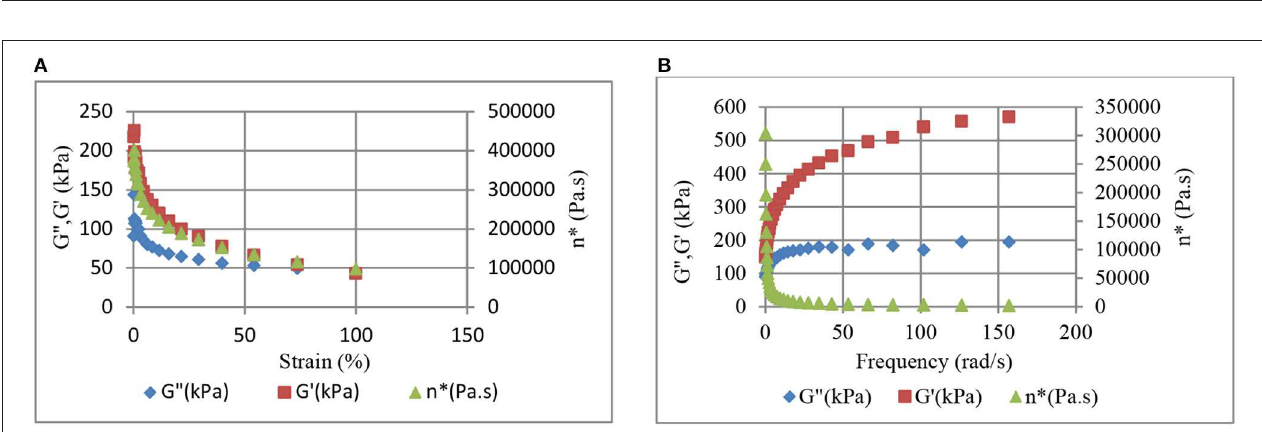
FIGURE 11 | Strain level (A) and frequency (B) dependent variation of storage (G’) and loss (G”) moduli, and dynamic viscosity ( η * ) in 40 phr CB-NR